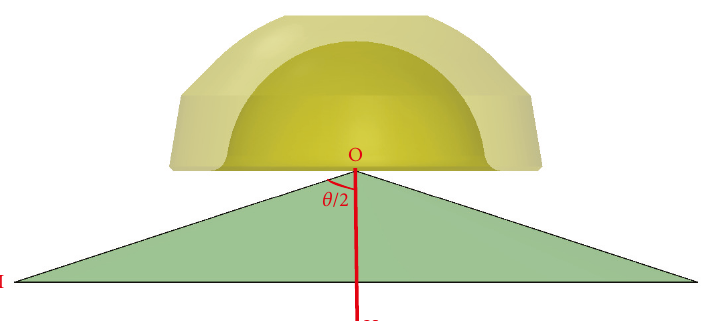
Figure 10: Cup cone.